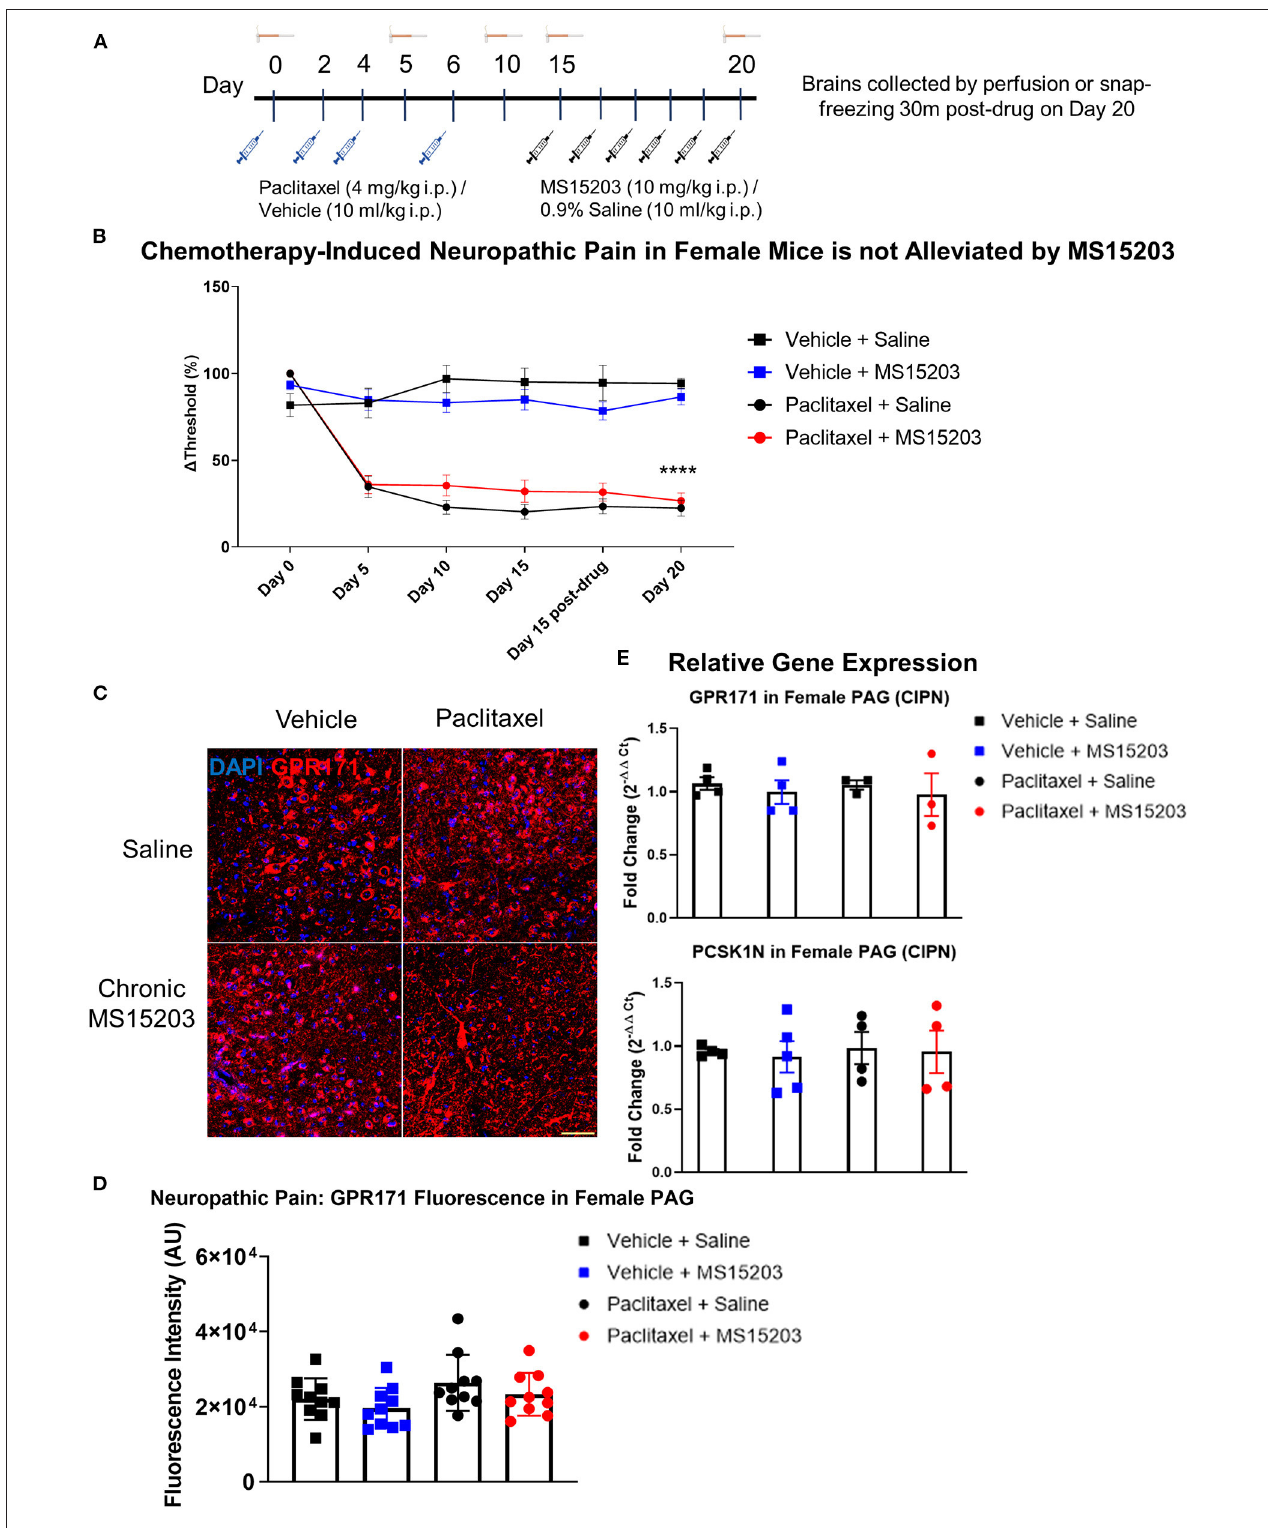
FIGURE 3 | MS15203 does not reduce chronic neuropathic pain in female mice. (A) An illustrative timeline describing the experimental design of chemotherapy-induced peripheral neuropathy followed by MS15203 treatment. (B) Female mice ( n = 6–7/group) treated with paclitaxel (16 mg/kg cumulative, i.p.) developed allodynia by Day 5 of the study as measured by the von Frey test. Chronic treatment with MS15203 from Day 15 through Day 20 failed